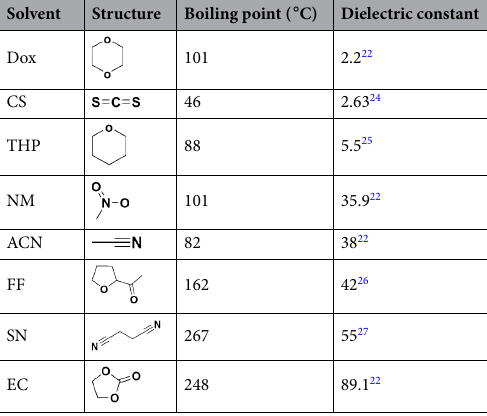
Table 1. Physical and chemical properties of ACN, THP, Dox, CS, NM, FF, AN, and EC solvents.